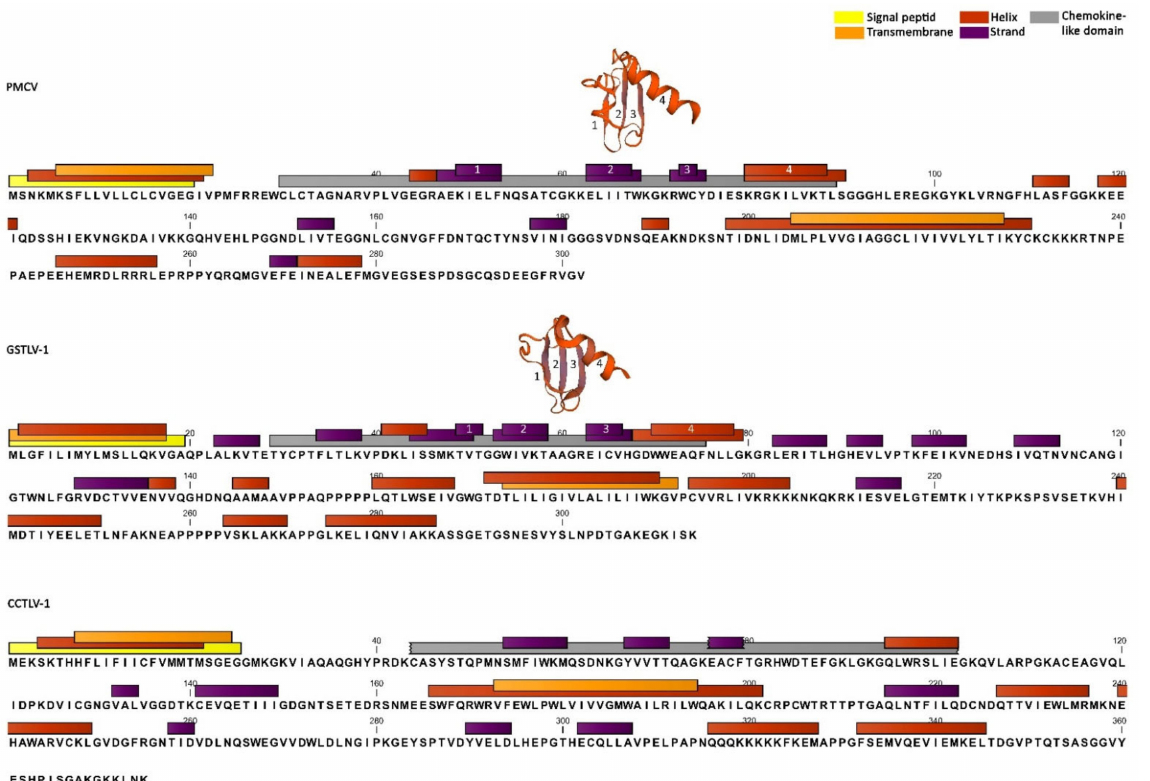
Figure 4. Overview of predicted domains for signal peptide, chemokine-like domain, transmembrane region and predicted α -helices and β -strands for PMCV ORF3, GSTLV-1 ORF3 (314aa), and CCTLV-1 ORF3. Predicted 3D models of chemokine- like domain are included for PMCV and GSTLV-1 close to the domain in the sequence and the three strands and one helix are marked by numbering corresponding between sequence and 3D model. The models are predicted against platelet factor 4, i.e., CXC chemokine 4 and CC chemokine 2, respectively. One predicted β -strand with low quality score is included for CCTLV-1, as it could have relevance for a tentative chemokine-like motif. This strand and also tentative chemokine-like motif are marked by tagged ends of bars to show high uncertainty of predictions/length. Predictions of hydrophobic regions are not included separately using colored bars but are consistent with signal peptide/transmembrane